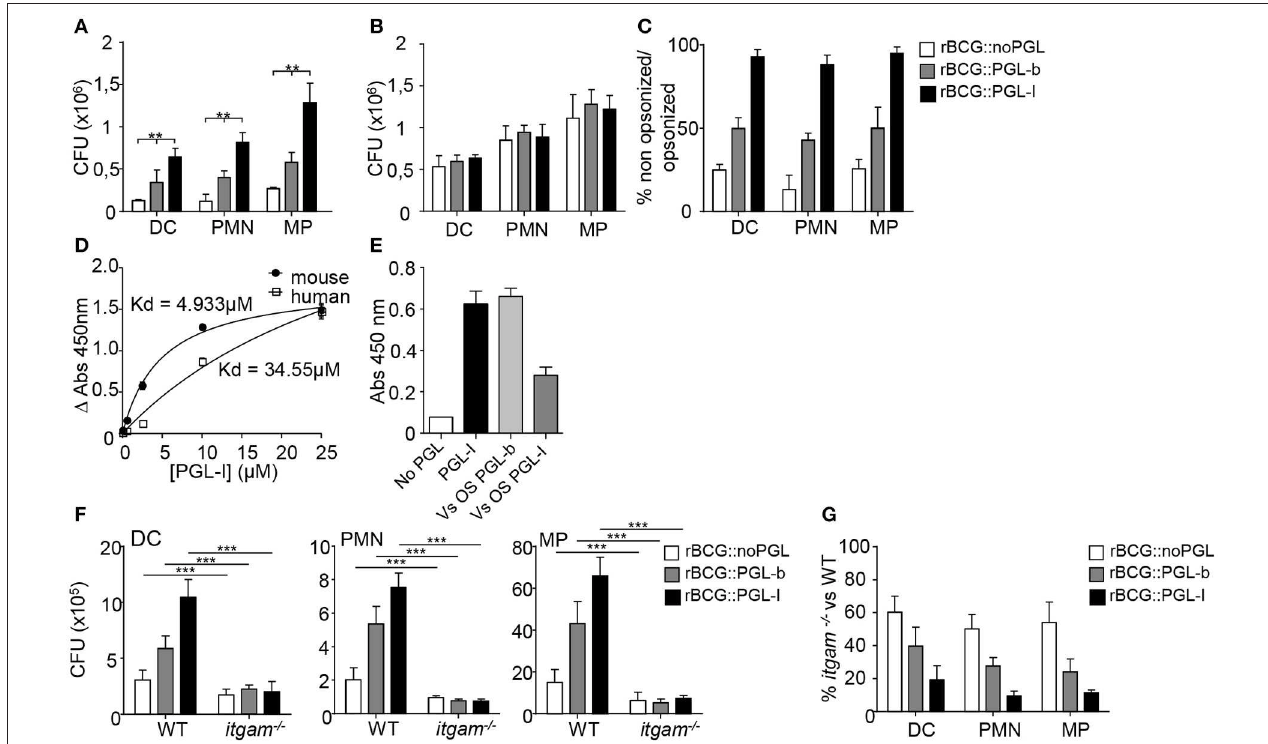
FIGURE 1 | Targeting of the lectin domain of CR3 by rBCG::PGL-I allows efficient infection of innate cells. (A,B) Number of CFUs recovered from bone marrow-derived DCs, PMNs and MPs after 2h infection with rBCG::noPGL, rBCG::PGL-b, or rBCG::PGL-I at MOI of 5 under serum-free conditions ( A, n = 8), or after 30min complement opsonizing with fresh mouse serum before contact with the cells ( B, n = 4). (C) Ratio of CFUs recovered for the three strains under non-opsonizing versus opsonizing conditions. (D) Binding of purified native PGL-I to recombinant human or mouse CR3. Absorbance values obtained after indirect ELISA with anti- PGL-I antibodies and determination of the dissociation constant Kd ( n = 6). (E) Competition assay measuring binding of recombinant mouse CR3 to purified PGL-I in presence of the chemically synthesized oligosaccharide domains of PGL-b or PGL-I. Absorbance reveals bound CR3 measured by indirect ELISA with anti-CR3 antibodies ( n = 3). (F) Number of CFUs determined as in (A) for the thee strains after infection of DCs, PMNs or MPs derived from wild-type (WT) mice or itgam − / − mice deficient in CR3 ( n = 10). (G) Ratio of CFUs recovered from itgam − / − vs. WT cells in the three cell types for the three strains ( n = 10). Data are presented as mean ± SEM. ** P < 0.01; *** P <